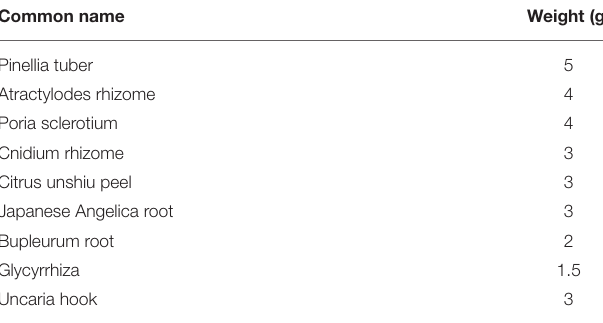
TABLE 1 | Medical herb composition of